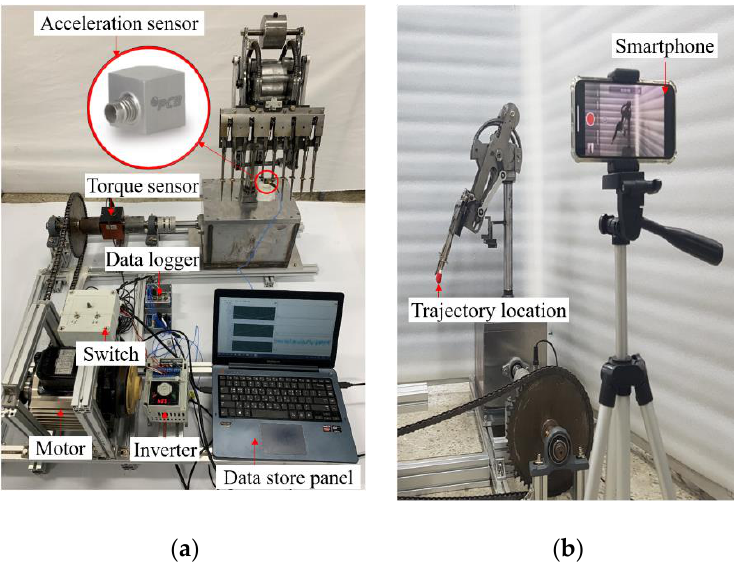
Figure 4. Validation test bench of the prototype picking device: ( a ) velocity, acceleration, and power measurement and ( b ) trajectory evaluation.